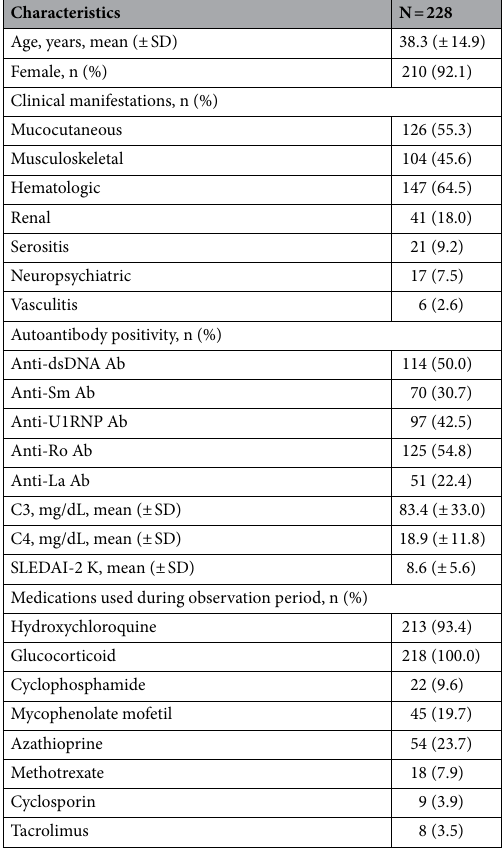
Table 1. Characteristics of the patients with SLE. SLE systemic lupus erythematosus; ds double-stranded; Ab antibody; SLEDAI-2 K systemic lupus erythematosus disease activity index 2000.